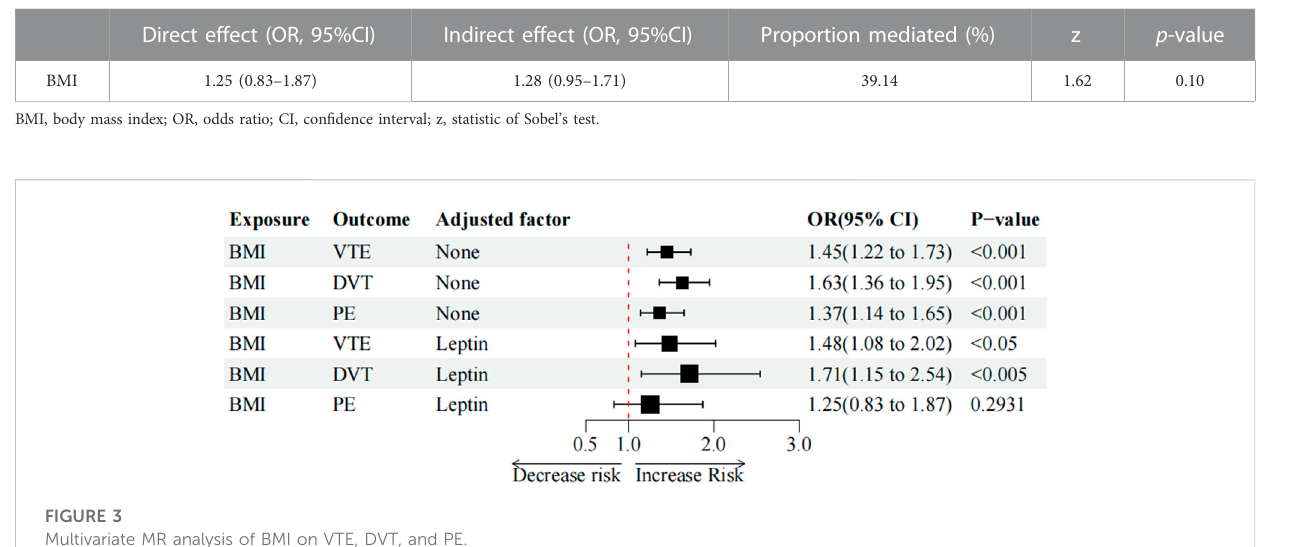
TABLE 6 Mediation analysis.